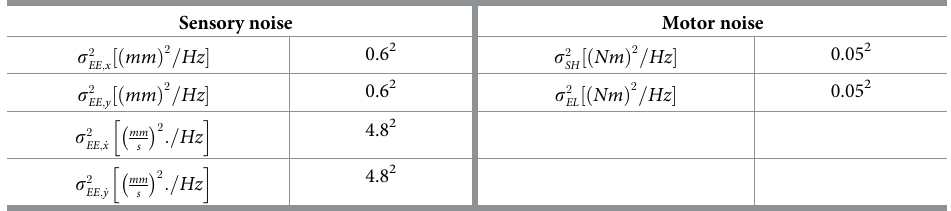
Table 4. Noise characteristics for goal-directed reaching